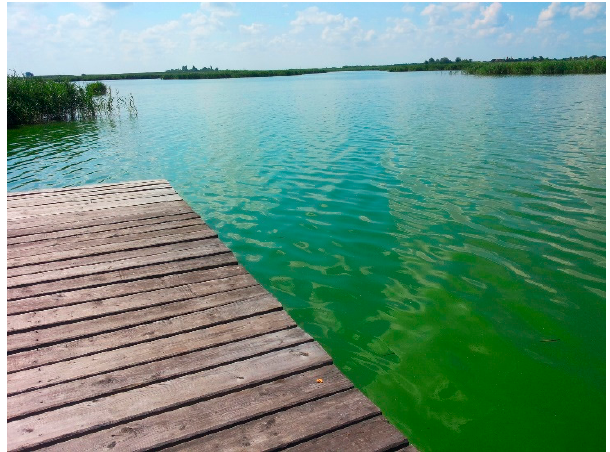
Figure 1. Pier view of the blooming Lake Ludoš in July 2018.